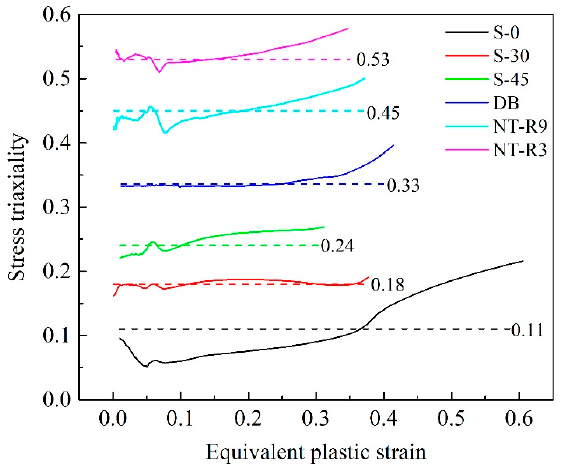
Figure 13. Evolution of stress triaxiality and integral mean value at fracture onset for six specimens.